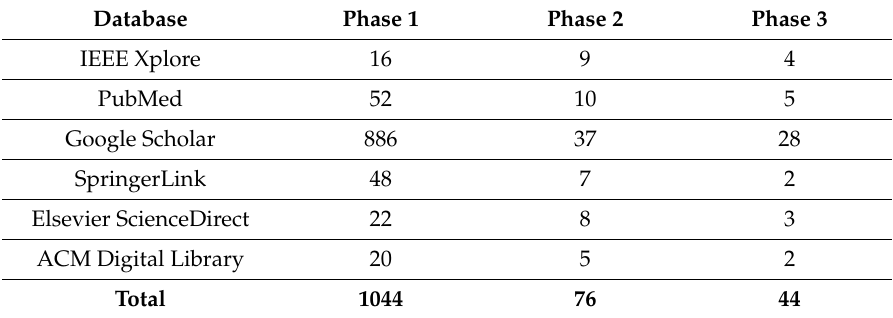
Table 2. The number of search result per database after applying three phases of the selection